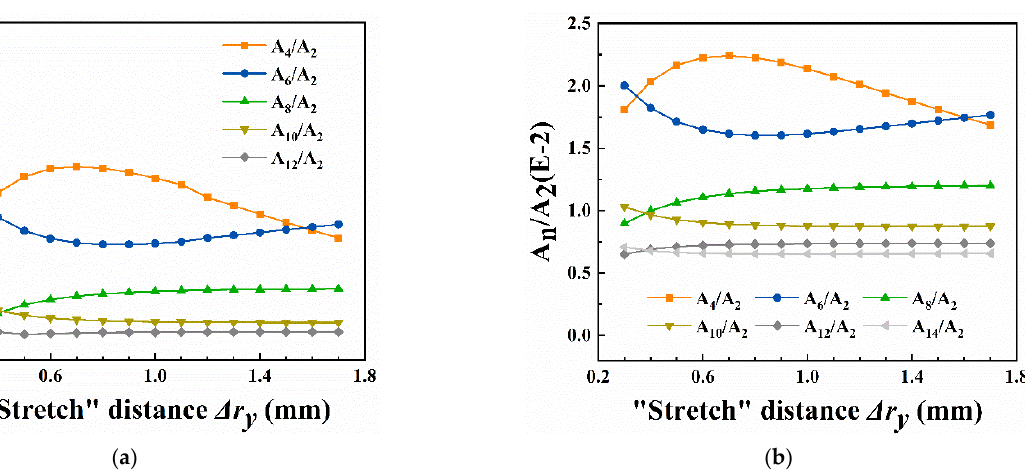
( b ) Figure 5. Mass spectrum of 2-slit model ( r x = 1.4 mm) when ( a ) Δ r y = 1.6 mm; ( b ) Δ r y = 1.7 mm. Lower full width at half maximum (FWHM) with severe distortion limited the MS capability. The proportions of high-order fields are shown in Figure 6. In the 2-slit model, the A 4 /A 2 and A 6 /A 2 dominating MS capability kept at a high level and changed apparently during the electrodes “stretching” process. The A 8 /A 2 and higher-order fields were rela- tively low and varied slowly, so their impact on resolution, in contrast, was negligible. When Δ r y ranged within 0.9~1.3 mm, where A 4 /A 2 decreased rapidly with A 6 /A 2 increas- ing slightly, the 2-slit model offered almost the same high resolution. It is probably be-